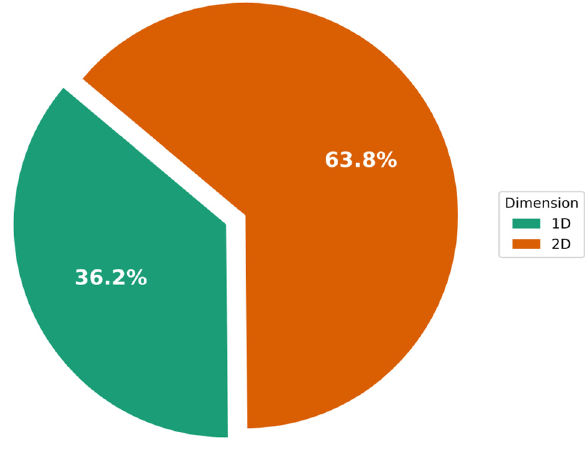
Figure 5. Percentages of IDS schemes that have used 1D or 2D (image) input shapes.